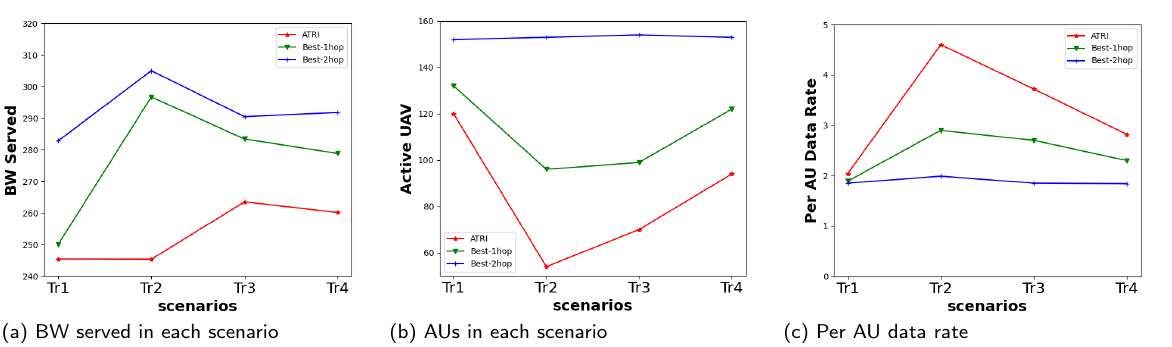
Figure 8. Comparing results on four training scenarios: ( a ) bandwidth served by deployed networks, ( b ) the number of AUs in the networks, and ( c ) per AU data